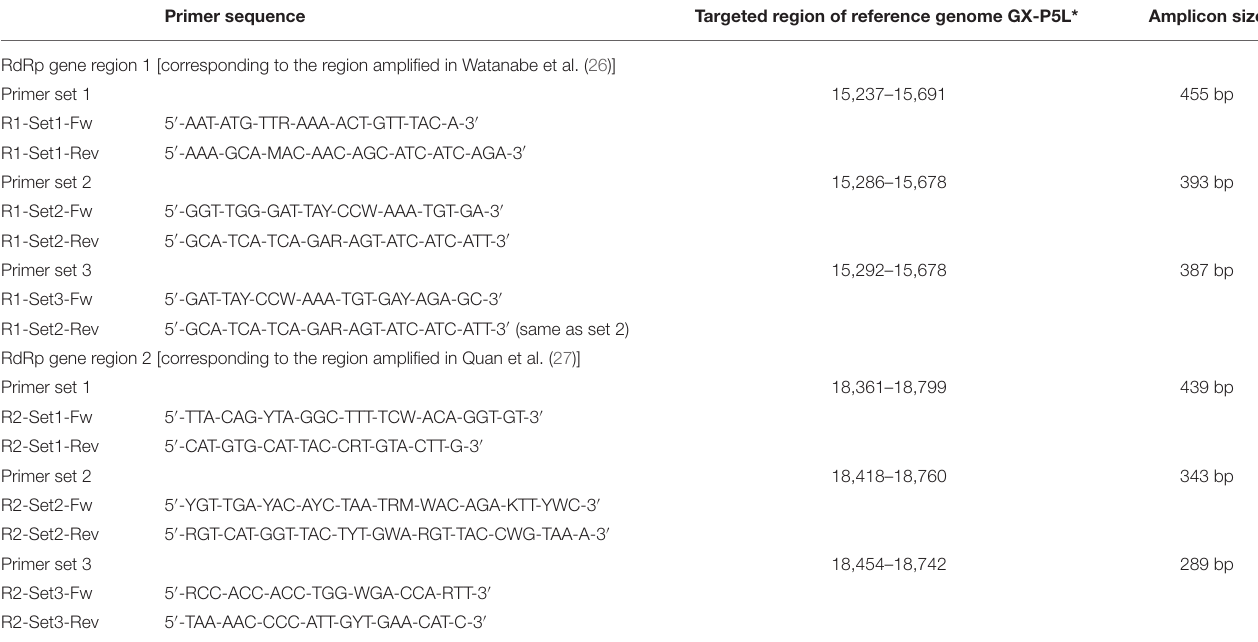
TABLE 2 | Primers designed for this study and corresponding targeted regions. Primer